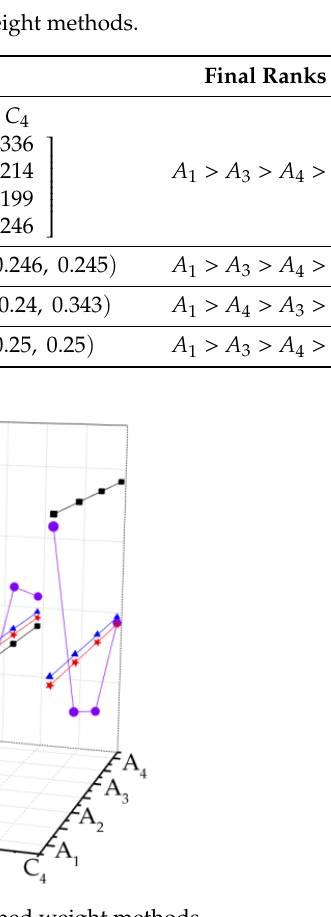
Figure 3. Comparison the comparison of mentioned weight methods.